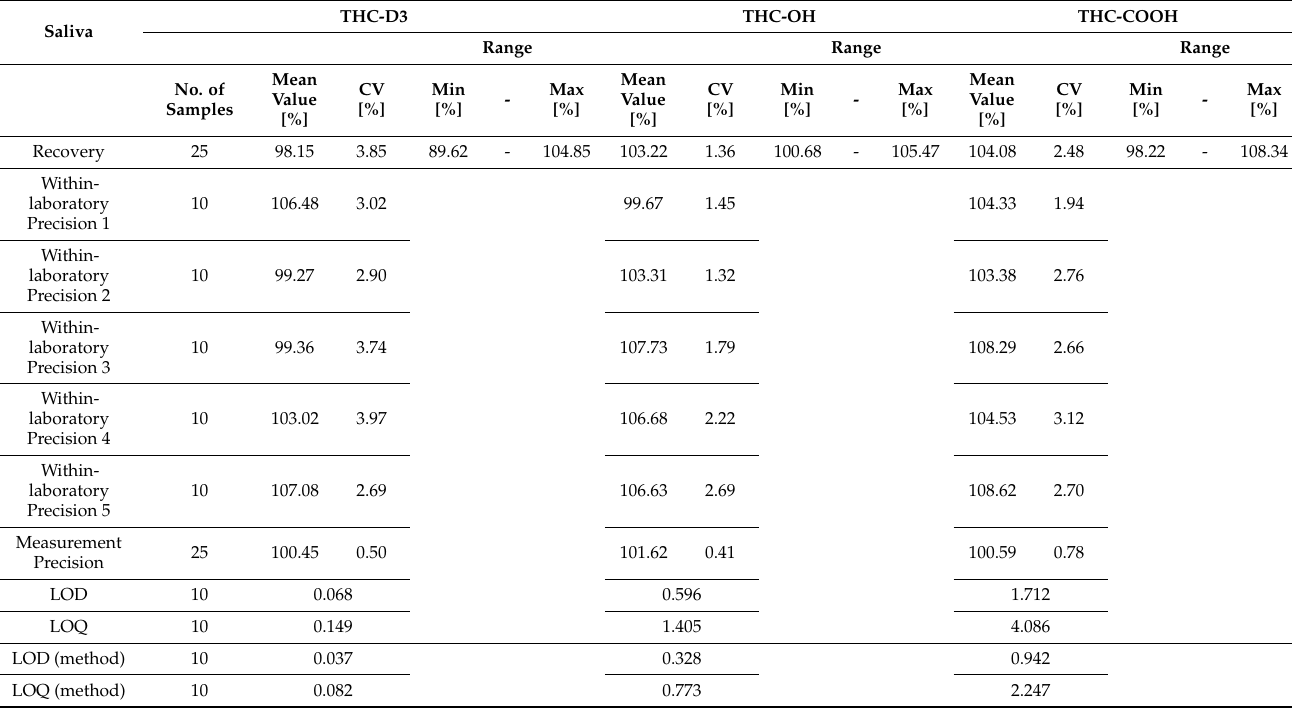
Table 3. Results of Method Validation for Cannabinoid Determination from